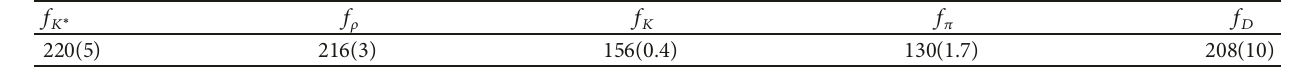
Table 5: The meson decay constants used in this paper (MeV) [57, 84].